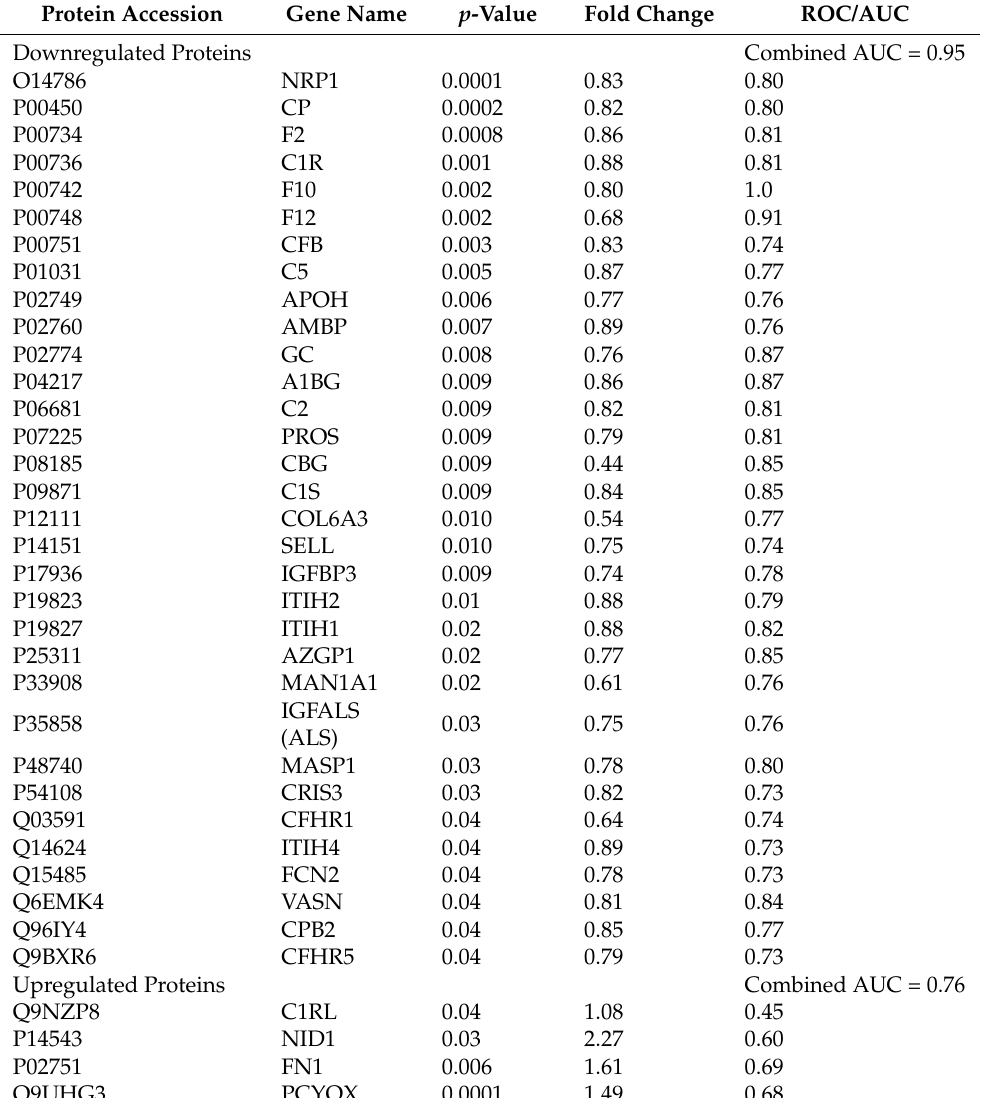
Table 2. Up- and down-regulated DEPs in